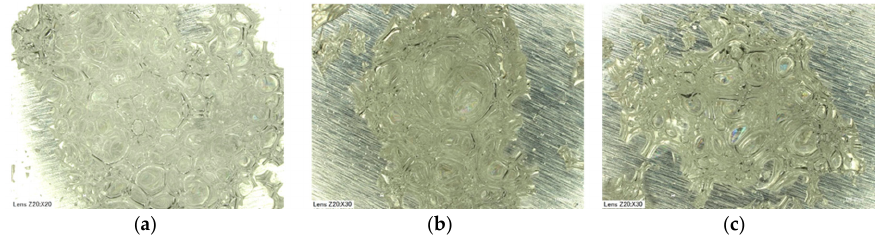
Figure 8. Numerical pictures of residues of ( a ) silicone, and ( b ) silicone/RDP, ( c ) silicone/BDP at 10 wt.% at 300 °C.